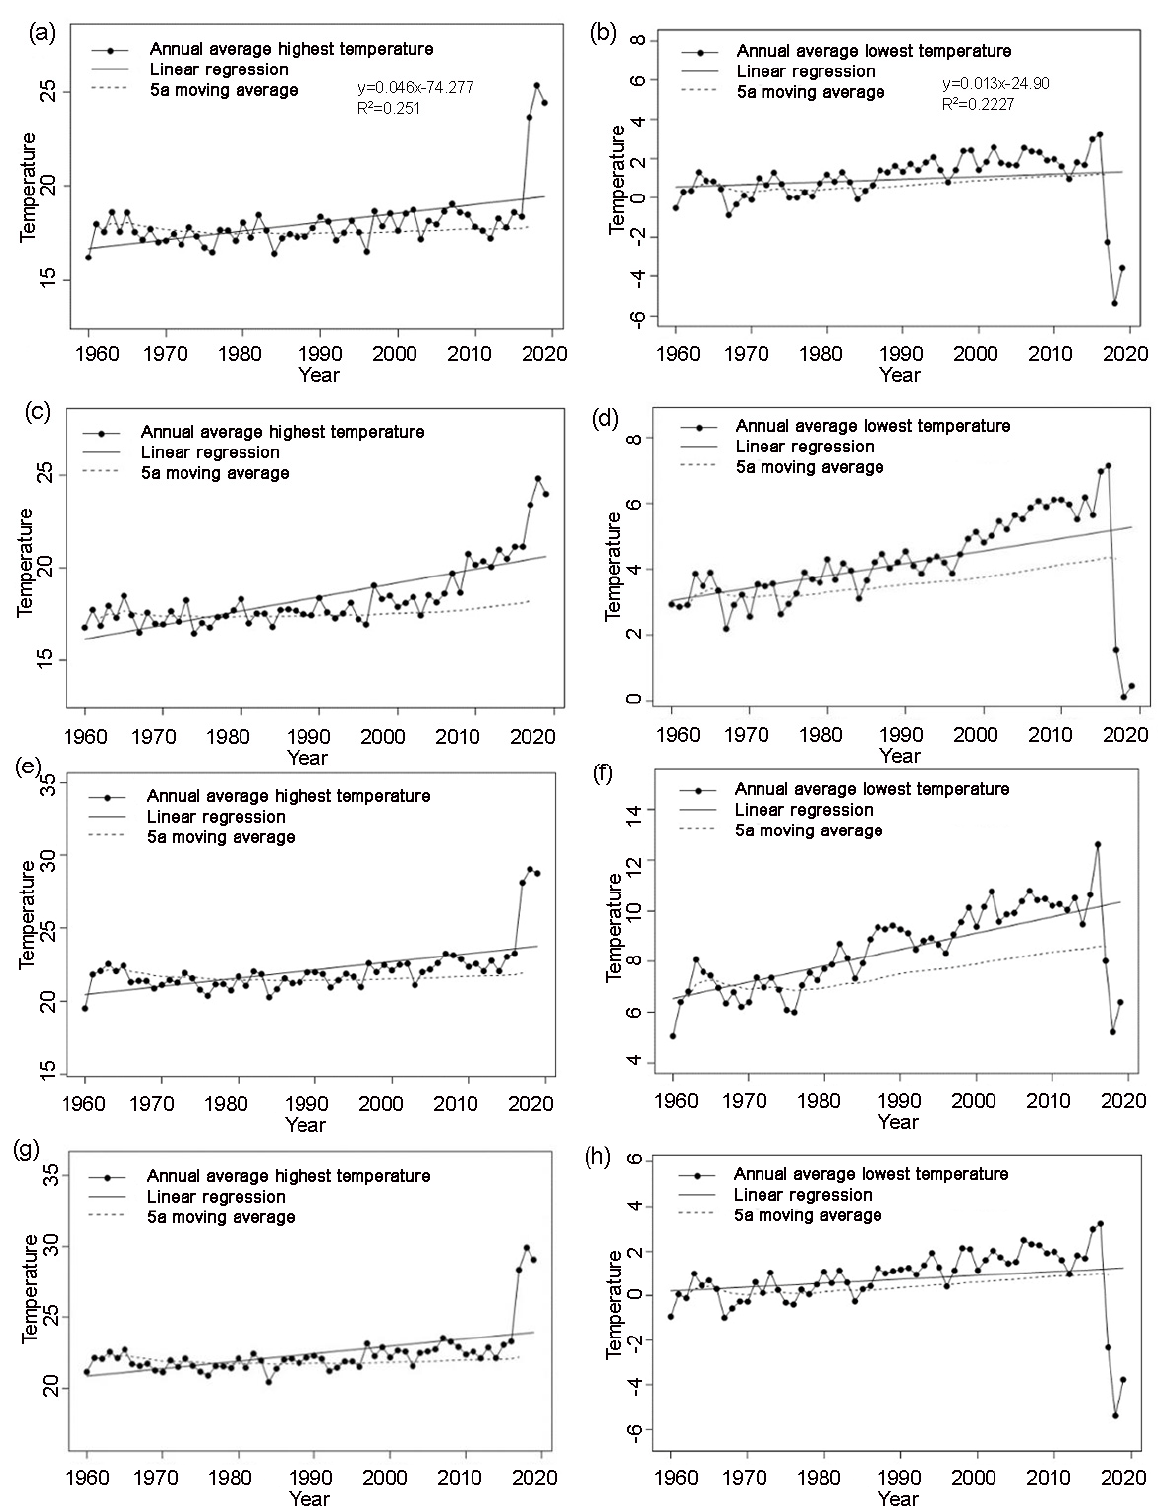
Figure 2. Annual average maximum ( a ) and minimum ( b ) temperature changes in the Turpan region in 1960 − 2019. ( a , b ) Kumishi ( c , d ) Shanshan ( e , f ) Turpan ( g , h ) Turpan region